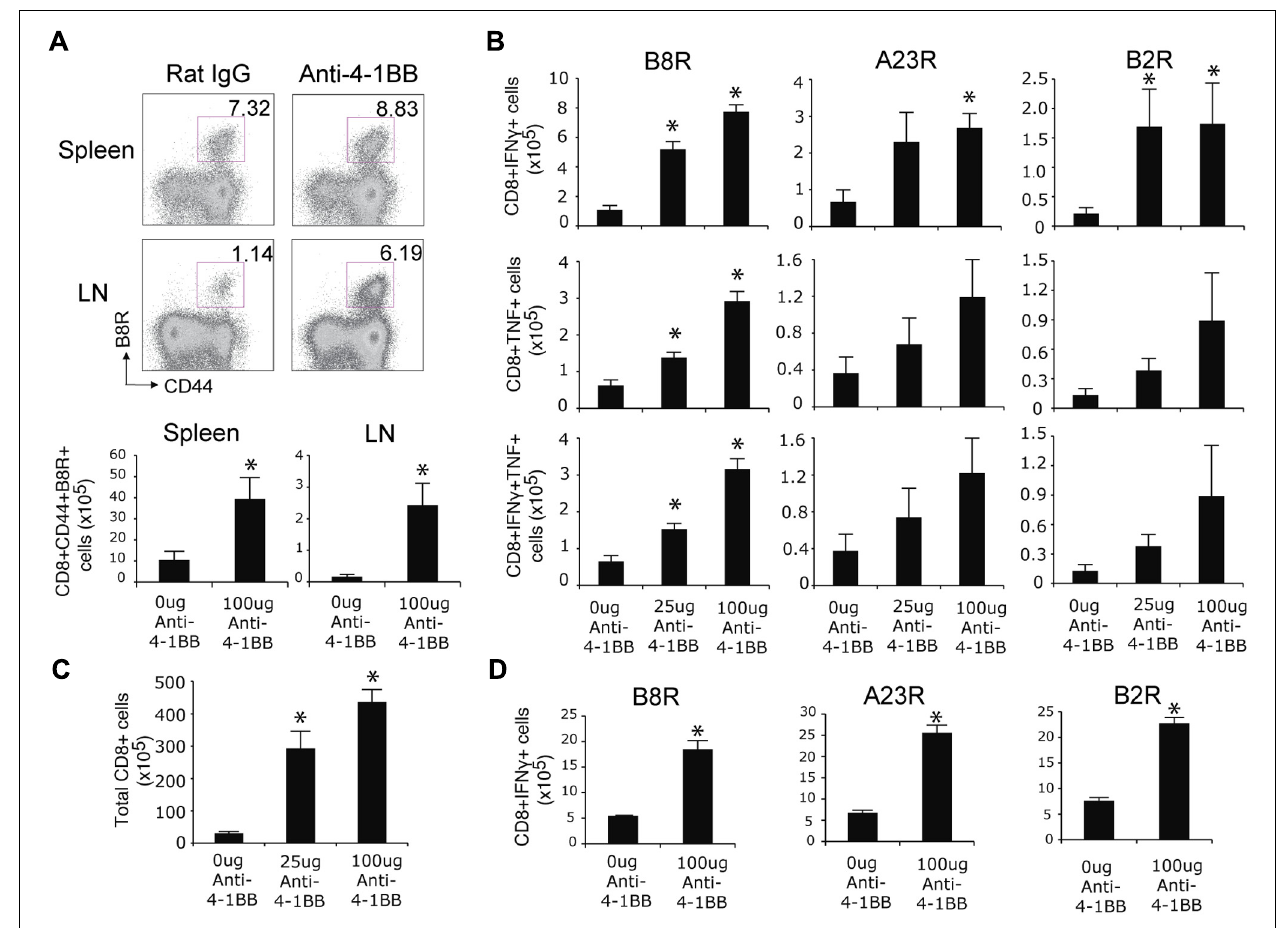
FIGURE 1 |Anti-4-1BB augments primary CD8T cell responses to VACV-WR. WT mice were infected i.p. withVACV-WR (2 × 10 4 PFU/mouse) and treated with 0, 25, or 100 μ g agonist anti-4-1BB or control antibody on day 1 post-infection. Seven days after infection, (A) Cells from spleen and peripheral lymph nodes (LN) were stained with anti-CD8, -CD44, and B8R-tetramer. Top : Representative dot plots of gated CD8 + cells.The numbers indicate the percentage of CD8 + CD44 + B8R-tetramer-positive cells. Bottom :Total number of CD8 + CD44 + B8R-tetramer-positive cells in the spleen and LN were calculated. (B) Splenocytes were stimulated with B8R,